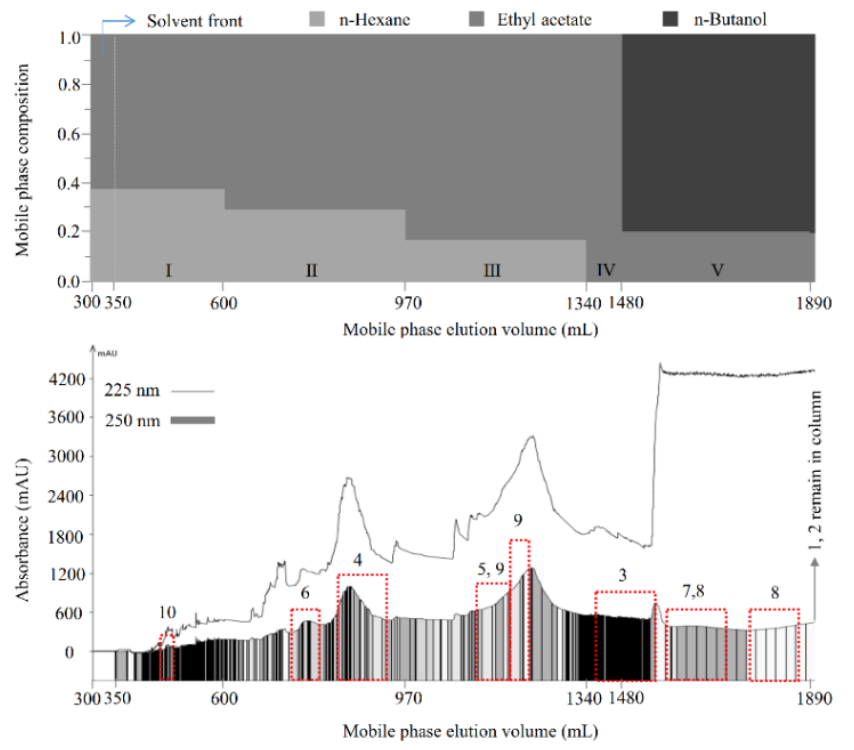
Figure 2. Separation of compounds by polarity-stepwise elution counter-current chromatography (CCC). Solvent methanol/water (1:5, v / v ) was used as the stationary phase. Ten compounds from the 70% methanol extract of M. volcanica, with polarities from low to high, were sequentially separated or fractionated by polarity-stepwise elution CCC using five mobile phases at 3 mL/min as follows: mobile phase I, n -hexane/ethyl acetate 3:5, v / v , 350–600 mL; mobile phase II, n -hexane/ethyl acetate 2:5, v / v , 600–970 mL; mobile phase III, n -hexane/ethyl acetate 1:5, v / v , 970–1340 mL; mobile phase IV, ethyl acetate, 1340–1480 mL; mobile phase V, ethyl acetate/ n -butanol 4:1, v / v , 1480–1890 mL. The n -butanol used was pre-saturated with water in the present study. The eluate was monitored at 225 nm (line) and 250 nm (rectangle) and automatically collected according to 250